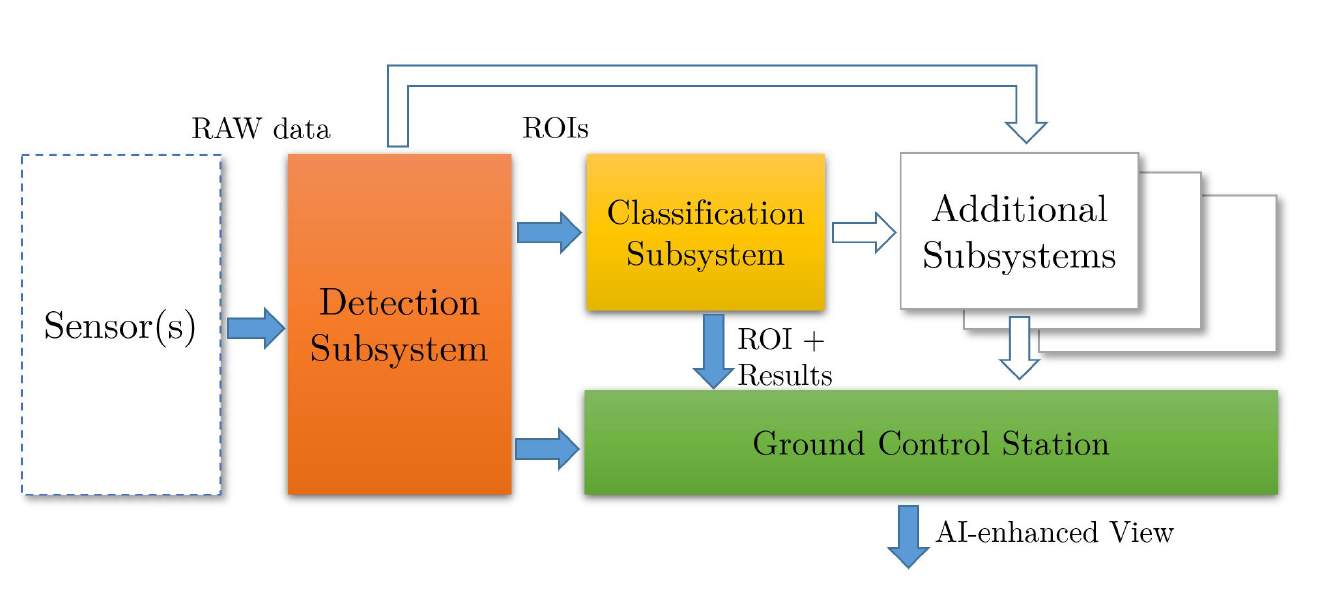
Figure 1. System architecture data